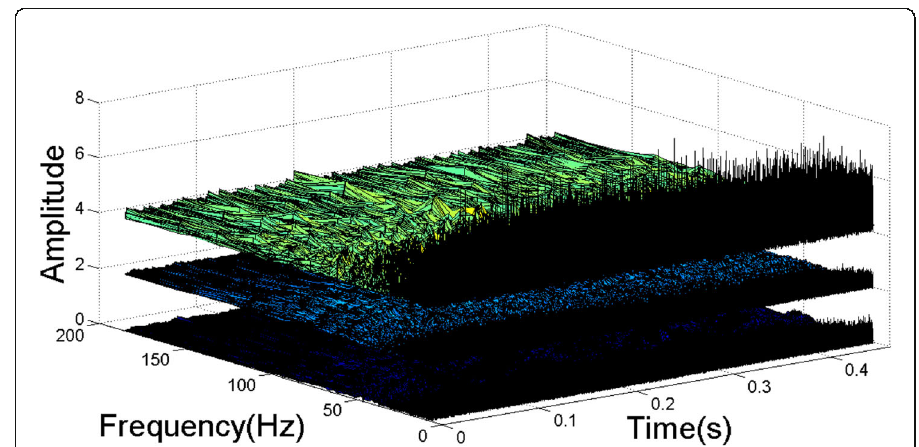
Fig. 20 Time-frequency diagrams of 3 vibration signals under fault state S4